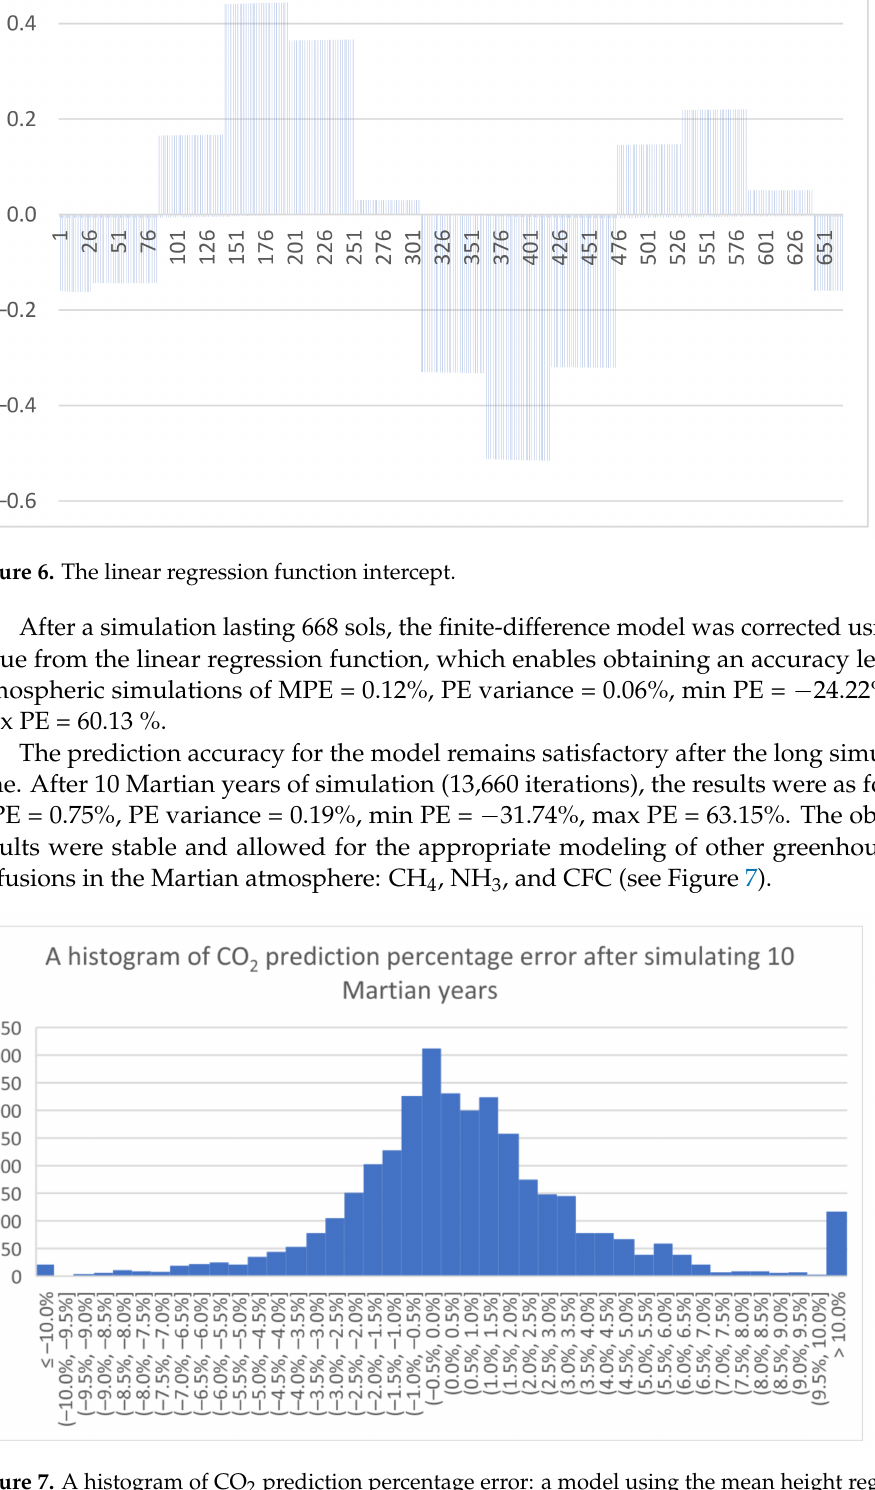
Figure 7. A histogram of CO 2 prediction percentage error: a model using the mean height regression function after 10 Martian years (a model with mean height difference and linear regression after 10 Martian years/the FDM model with linear regression after 10 Martian